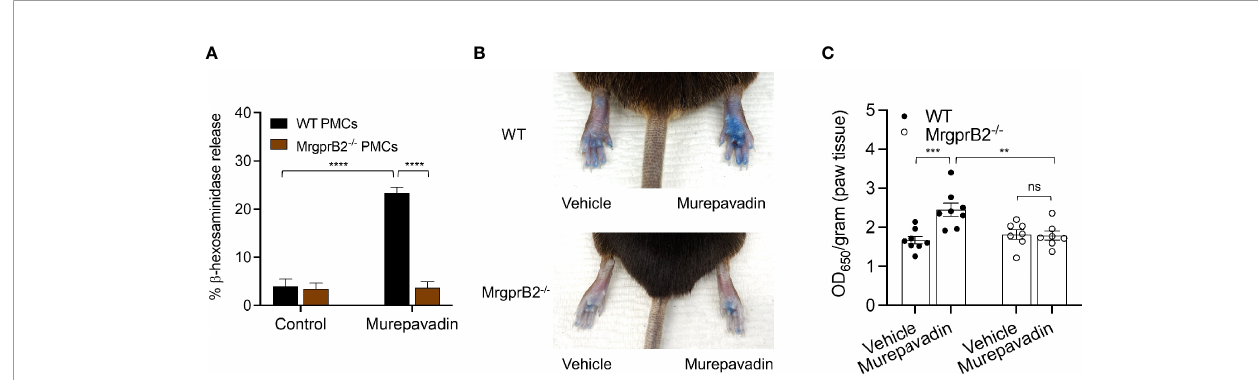
FIGURE 6 | Murepavadin activates murine MCs in vitro and in vivo via MrgprB2. (A) WT and MrgprB2 -/- PMCs were exposed to 10 m M murepavadin (30 min) and degranulation was assayed by measuring the release of b -hexosaminidase. (B) Representative images of Evan ’ s blue dye extravasation in WT and MrgprB2 -/- mice in vivo. Mice were intradermally injected with 20 m L of murepavadin (30 m M) or PBS, and extravasation of Evan ’ s blue dye was determined after 30 min. (C) Quanti fi cation of extravasation of Evan ’ s blue dye in WT and MrgprB2 -/- mice (n = 7-8). Statistical signi fi cance was determined by two-way ANOVA with Tukey ’ s multiple comparisons at a value ** p < 0.01, *** p < 0.001, **** p < 0.0001, and ns denotes “ not signi fi cant ” .